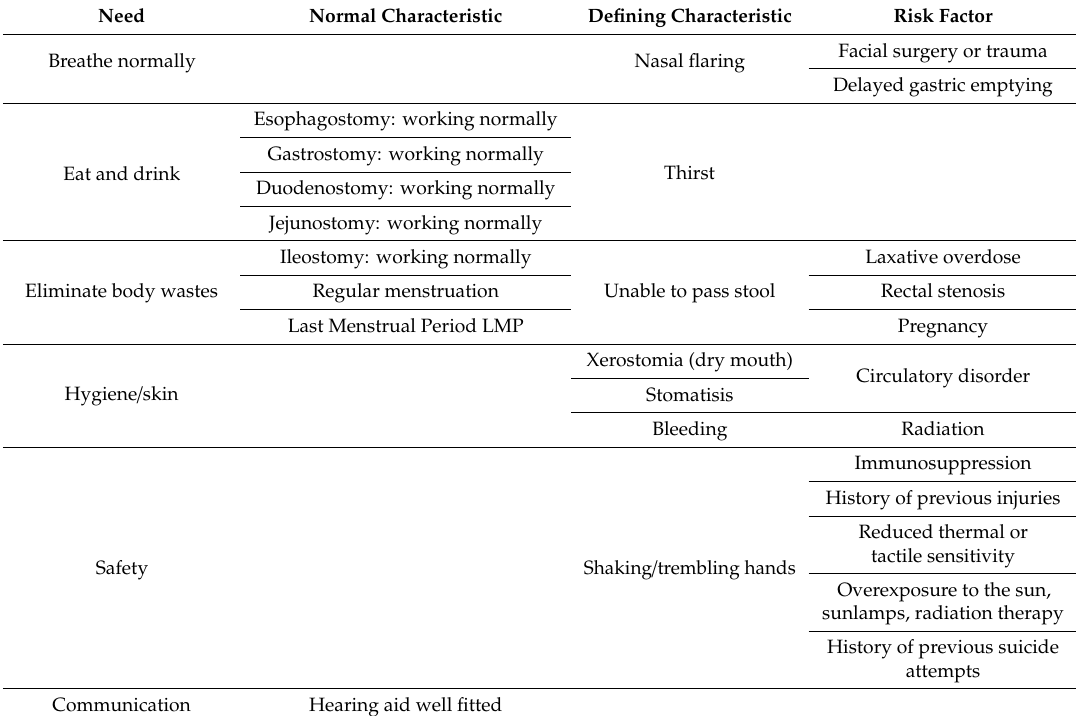
Table 2. Normal characteristics, defining characteristics and risk factors not selected.